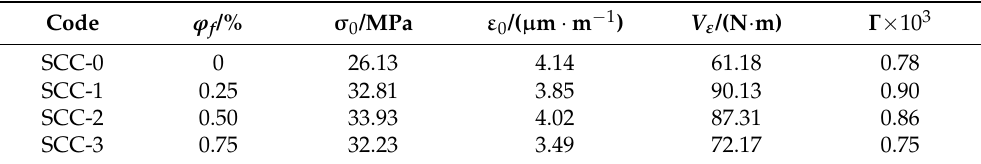
Table 7. Parameters of the axial compression property of steel-fiber-reinforced SCC containing a high level of fly